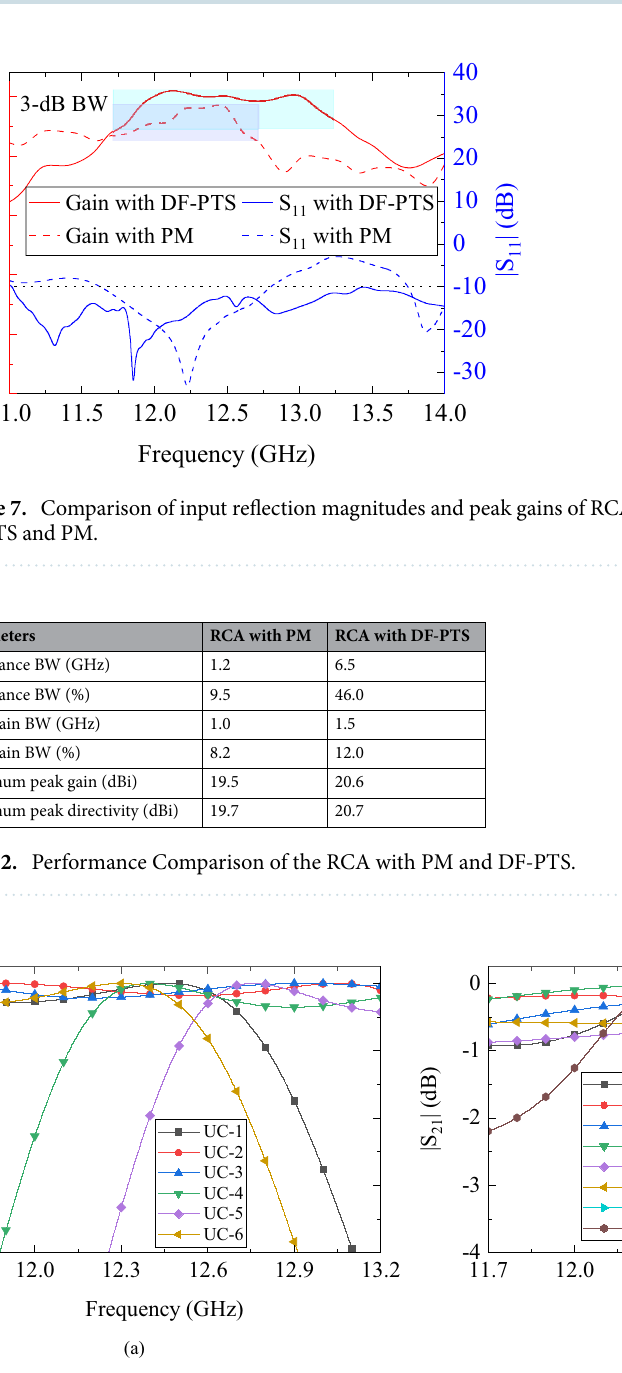
Figure 8. Transmission magnitudes of ( a ) DF-PSCs selected to design the DF-PTS, and ( b ) P-PSCs selected to design the